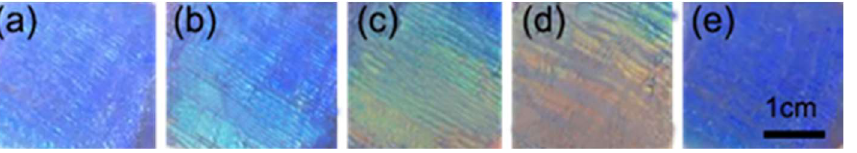
Figure 7. The structural color of the SF-PNIPAM dual-crosslinked nanocomposite film (2 mm) with different deformations ( a ) 0%; ( b ) 5%; ( c ) 10%; ( d ) 15%; ( e ) Remove external force.